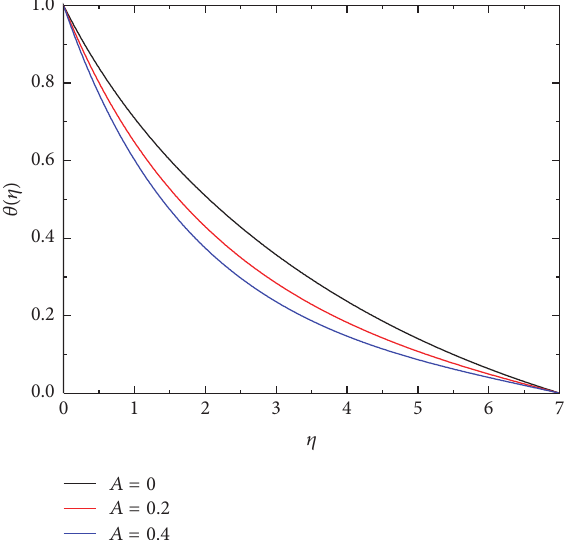
Figure 13: Microrotation profiles for various values of 𝜉 when 𝐴 = 0.2 , 𝑅 = 0.5 , and 𝐾 = 0.2